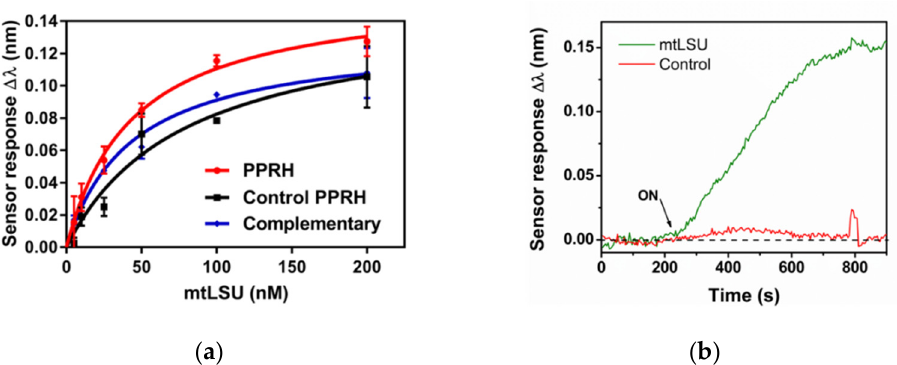
Figure 4. mtLSU rRNA gene detection. ( a ) Calibration curves of mtLSU rRNA on SSC 2.5 X + 5% FA buffer. Sensor response represents the mean ± SD of three measurements in a PPRH: CH 3 –PEG (1:1) receptor monolayer. ( b ) Real-time monitoring of the wavelength displacements ( Δ λ vs. time) corresponding to the hybridization of 100 nM mtLSU rRNA analyte and DNA control sequences using SSC 2.5 X + 5% FA buffer. Table 1. Nucleotide sequences, length and CG percentage of the employed mtLSU rRNA analyte and control sequence.